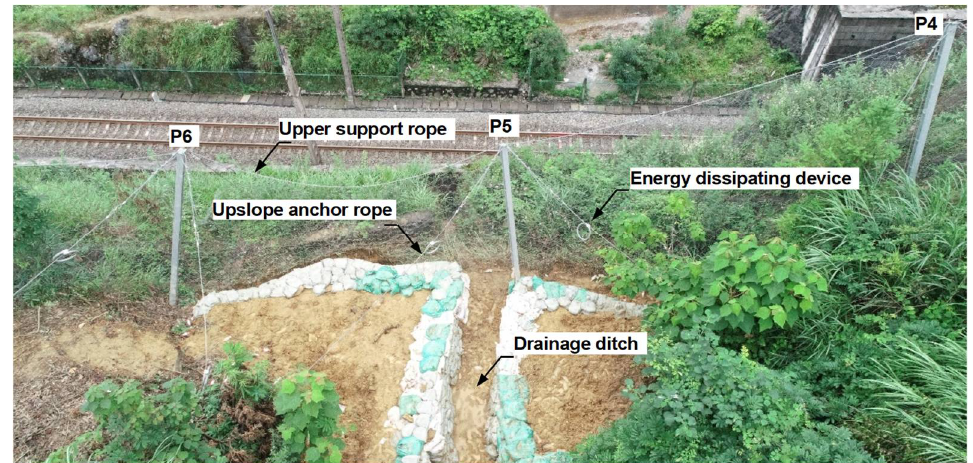
Figure 5. An overall view of the landslide site after maintenance.